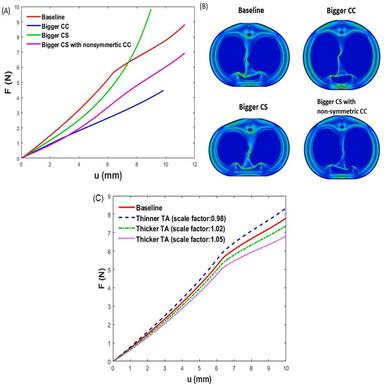
Influence of morphological variations of the penis on its overall mechanical response in the compression test; (A) the force-displacement responses of four cases, (B) the compression mechanisms for each case, and (C) the force-displacement responses for different TA thicknesses.